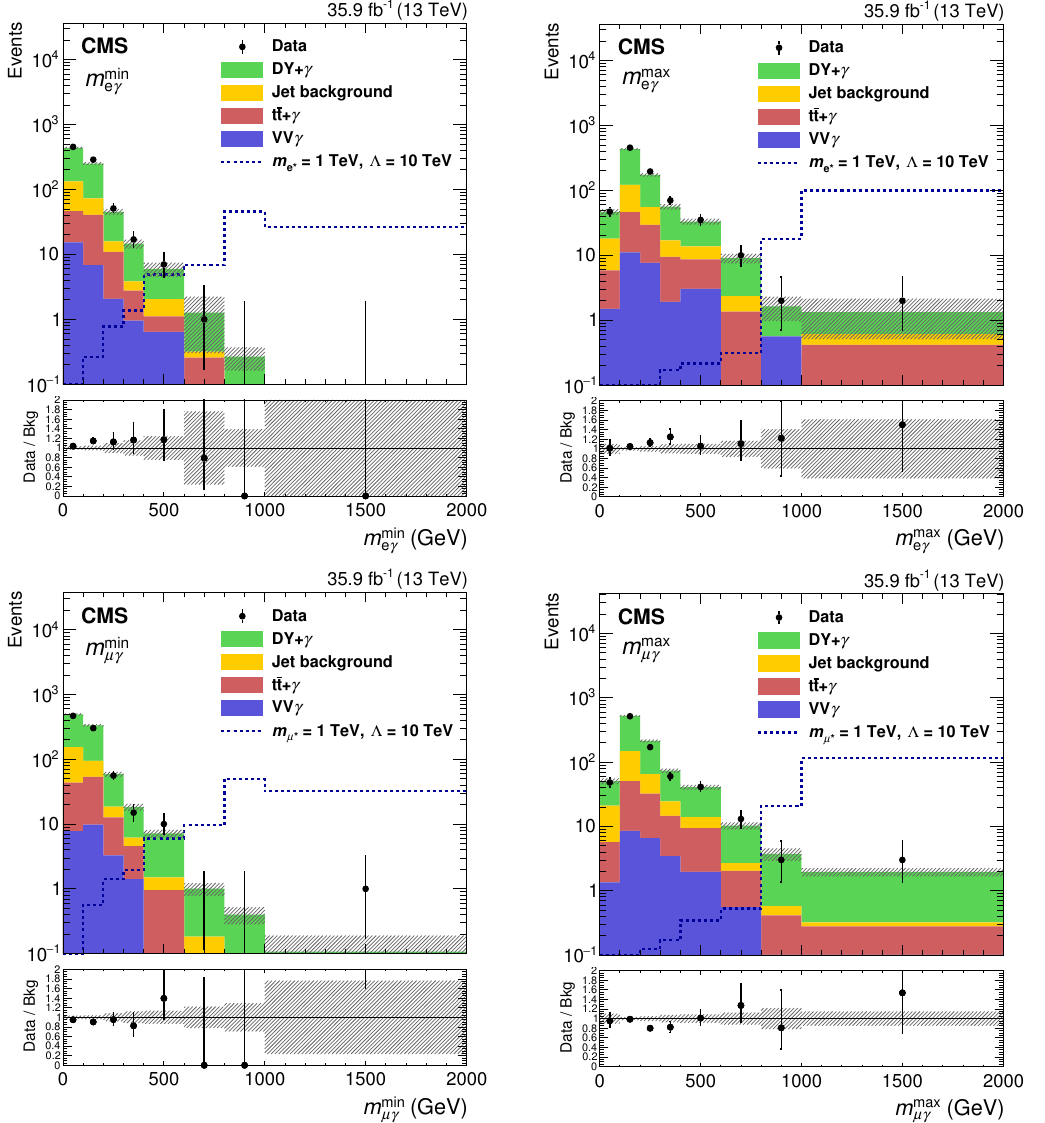
Figure 2 . The distributions of m min (left column) and m max (right column) in the ee (cid:13) channel ‘(cid:13) ‘(cid:13) (upper row) and the (cid:22)(cid:22)(cid:13) channel (lower row). The points with error bars denote the data and the stacked histograms show the predictions for each of the backgrounds. The uncertainty bands of the SM prediction includes only statistical uncertainties. Signal events for m ‘ (cid:3) = 1 TeV at (cid:3) = 10 TeV are also shown as dotted lines. The last bin of each distribution includes over(cid:13)ow